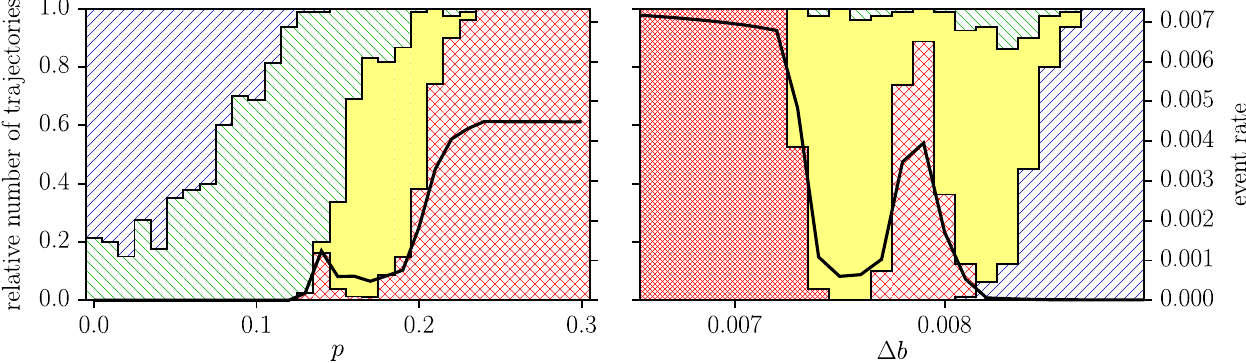
FIG. 3. Stacked histograms showing the relative number of trajectories exhibiting either pattern switching (yellow, solid) or convergence to one of the attractors A , B , or C ( A , low-amplitude oscillations: blue, north-east diagonals; B , traveling waves: green, south-east diagonals; C , global oscillations: red, crosshatched). Left: Influence of rewiring probability ( p , bin size 0.01) with a fixed parameter inhomogeneity ( Δ b ¼ 0 . 008 ). Right: Influence of parameter inhomogeneity ( Δ b , bin size 0.0001) with a fixed rewiring probability ( p ¼ 0 . 2 ). For each value of p and Δ b , the total number of trajectories is 80 (except for p < 0 . 1 and p > 0 . 24 , where it is 40). For each of those trajectories, we employ a different realization of the coupling topology (corresponding to that p ) and of the inhomogeneity (corresponding to that Δ b ). In the right-hand panel, narrow crosshatching indicates 1 0 global oscillations, and wide crosshatching indicates 1 1 global oscillations [75]. The black thick line is the event rate (number of times at which ¯ x rises above x divided by the observation time) averaged over all realizations. Almost all trajectories exhibiting pattern switching feature all three patterns, A, B, and